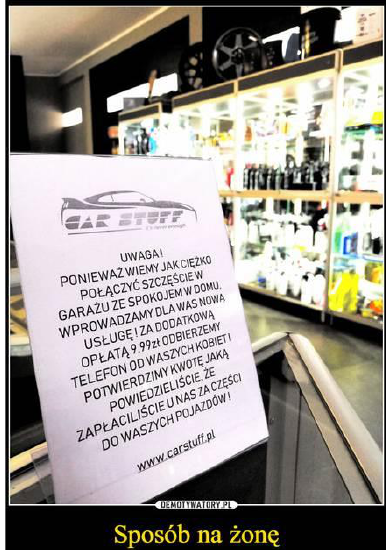
Figure 1. T-shirt of a fishing fanatic.